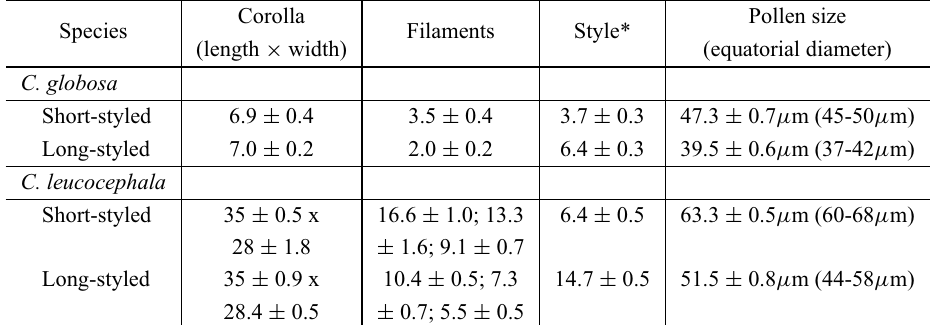
Measurements (mean ± SD, mm) of short- and long-styled flowers of Cordia globosa and C. leucocephala , and equatorial diameter (in polar view, μ m) of pollen grains (plants from a Caatinga area, Pernambuco State, Brazil).